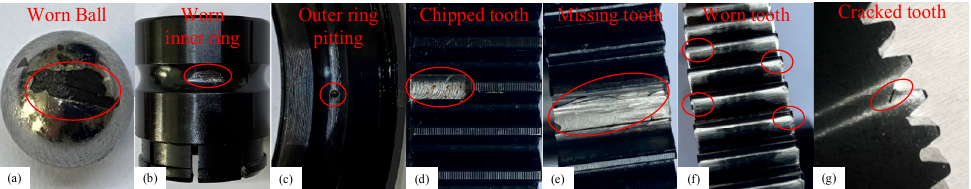
Figure 10. Faulty parts in the gearbox. (a) Bearing rolling body wear failure; (b) Bearing inner ring wear failure; (c) Bearing outer ring pi tt ing failure; (d) Gear tooth breakage failure; (e) Missing gear